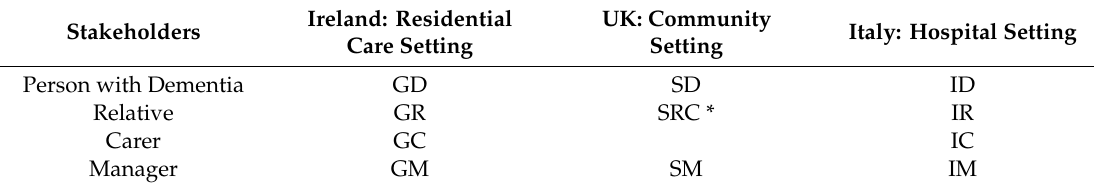
Table 2. Pilot site stakeholder